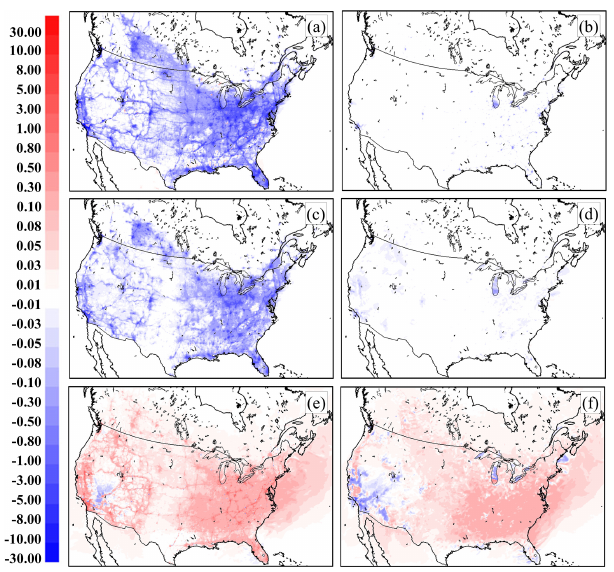
Figure 7. Difference in 29d average NO 2 , PM 2 . 5 , and O 3 , July 2016 continental 10km domain simulations (VIT simulation–No VIT simulation). Averages are paired at (a, c, e) 10:00UTC and (b, d, f) 22:00UTC according to species: (a, b) (cid:49) NO 2 (ppbv); (c, d) (cid:49) PM 2 . 5 (µgm − 3 ); (e, f) (cid:49) O 3 (ppbv).